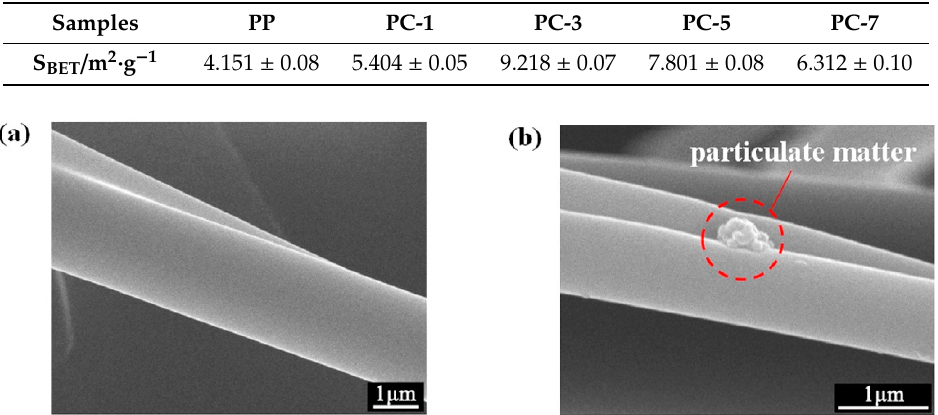
Figure 12. SEM images of PC-5 ( a ) before and ( b ) after 20 times of DEHS aerosol filtration test at membrane fiber surface groove.